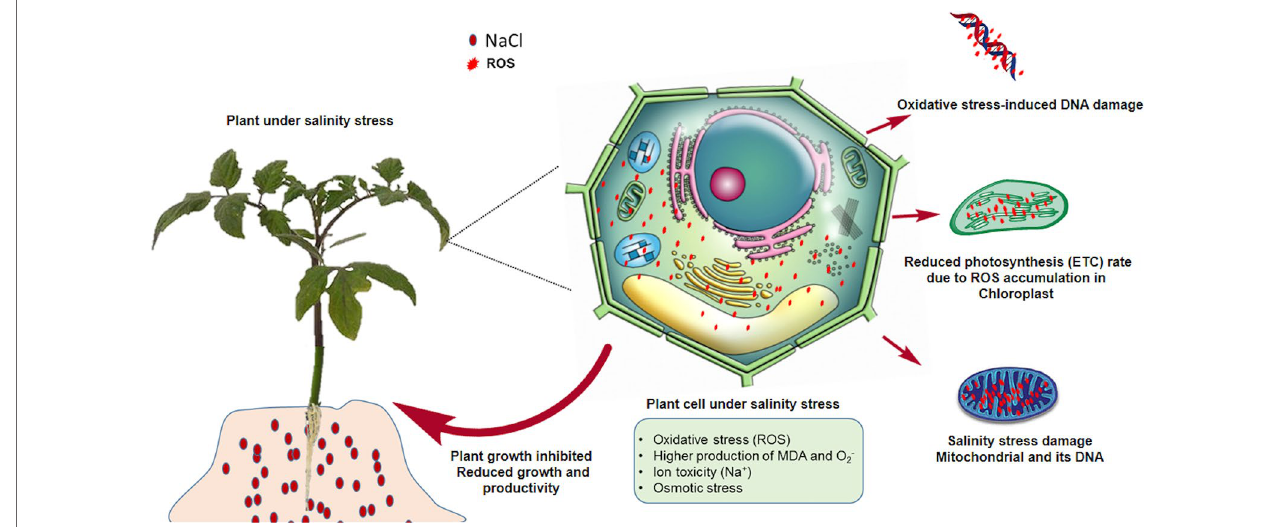
FIGURe 1 | Higher ROS levels in plants under salinity stress conditions. Toxic levels of ROS stunt plant growth by inhibiting the electron transport chain, and photosynthesis in plastids, and by causing mutations in DNA and damaging mitochondria.